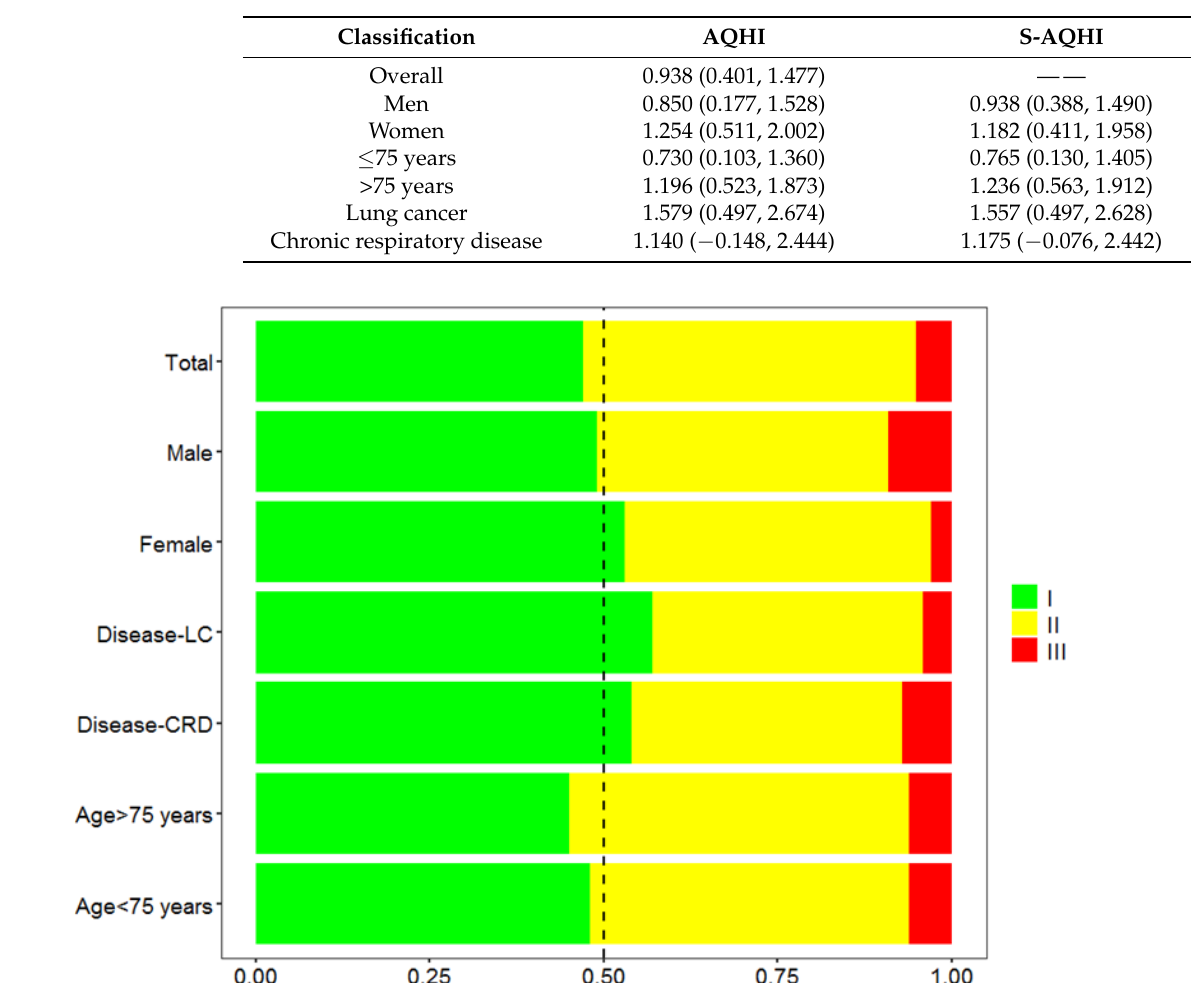
Table 4. Effects of the AQHI and S-AQHI on daily mortality in various populations in Beijing (%).